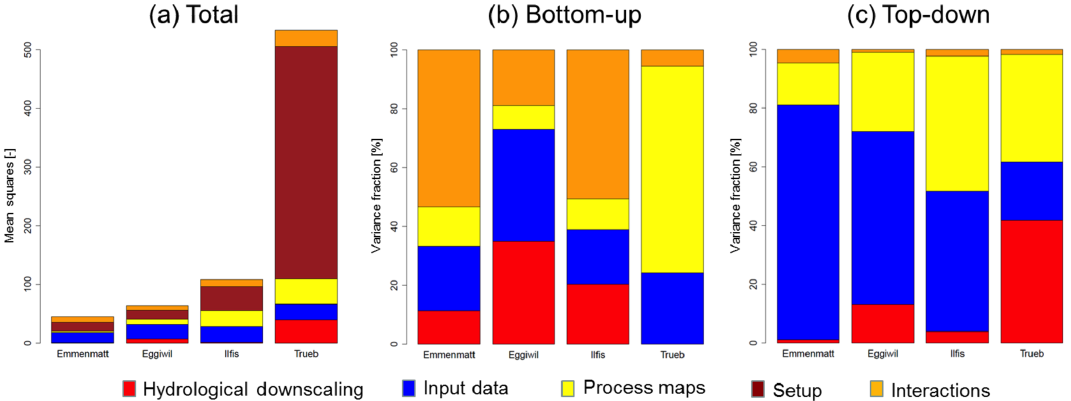
Figure 11. Decomposition of the model performance (KGE) variance at the four gauging stations for all the modelling chain combina- tions (a) , as well as for those based on the bottom-up (b) and top-down (c) configurations. Total uncertainty increases with decreasing size of the